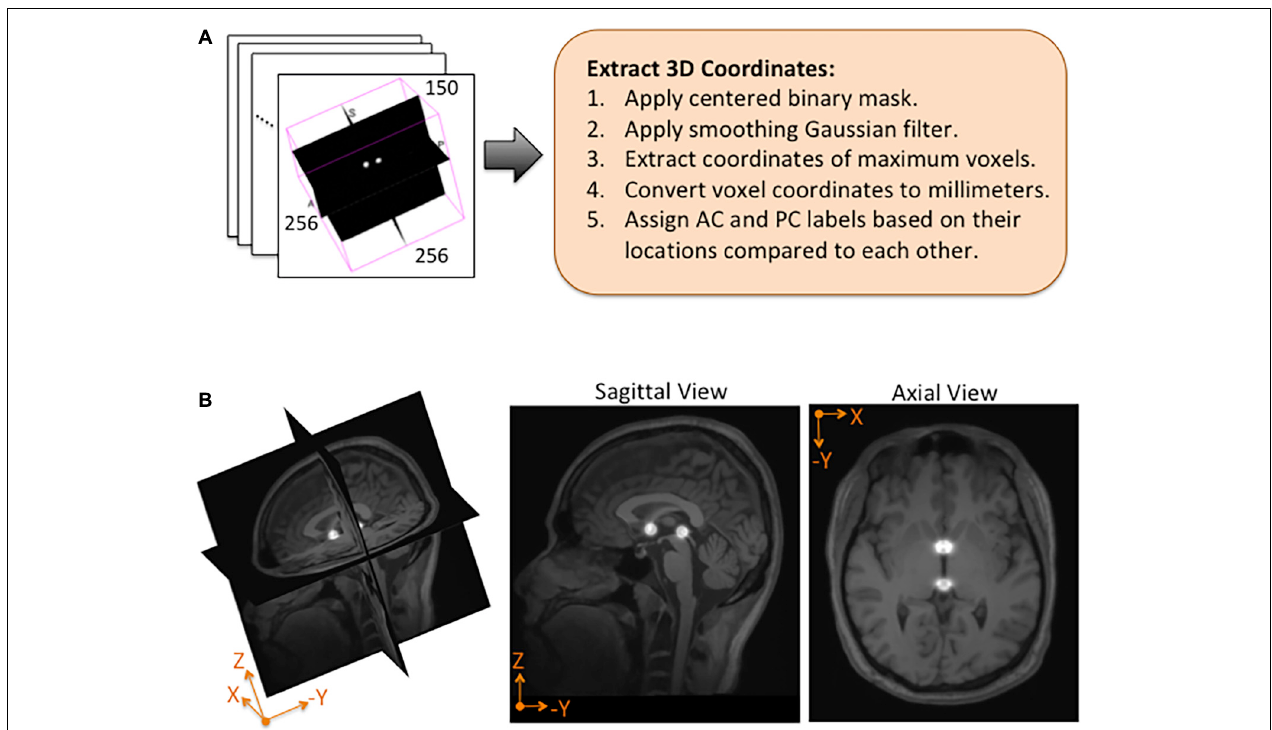
FIGURE 4 | Post-processing and overlay visualizations of a predicted AC-PC heatmap volume. (A) The 3D coordinates of AC and PC points are extracted from each predicted heatmap volume. (B) Visualizations of a post-processed predicted heatmap overlaid on its corresponding MRI scan. The radius of the spheres is approximately 7.5